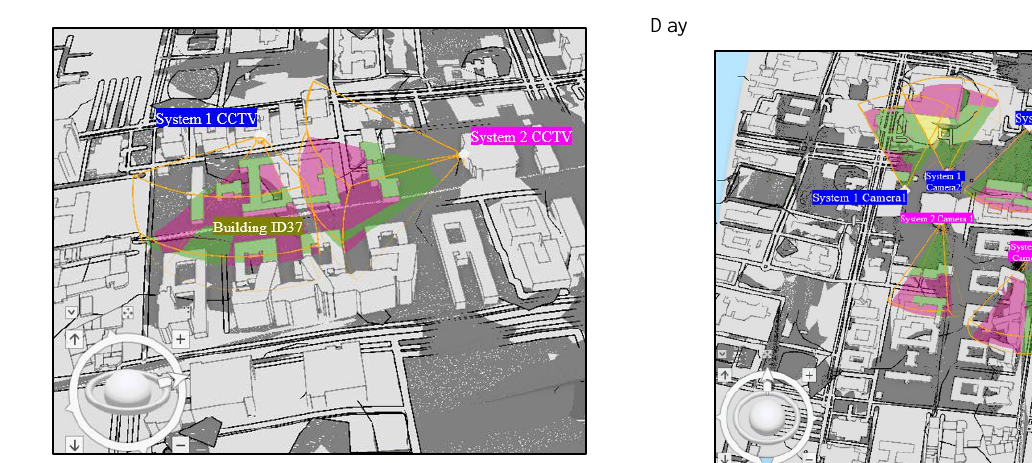
Figure 7. multiple CCTV systems coverage at daytime